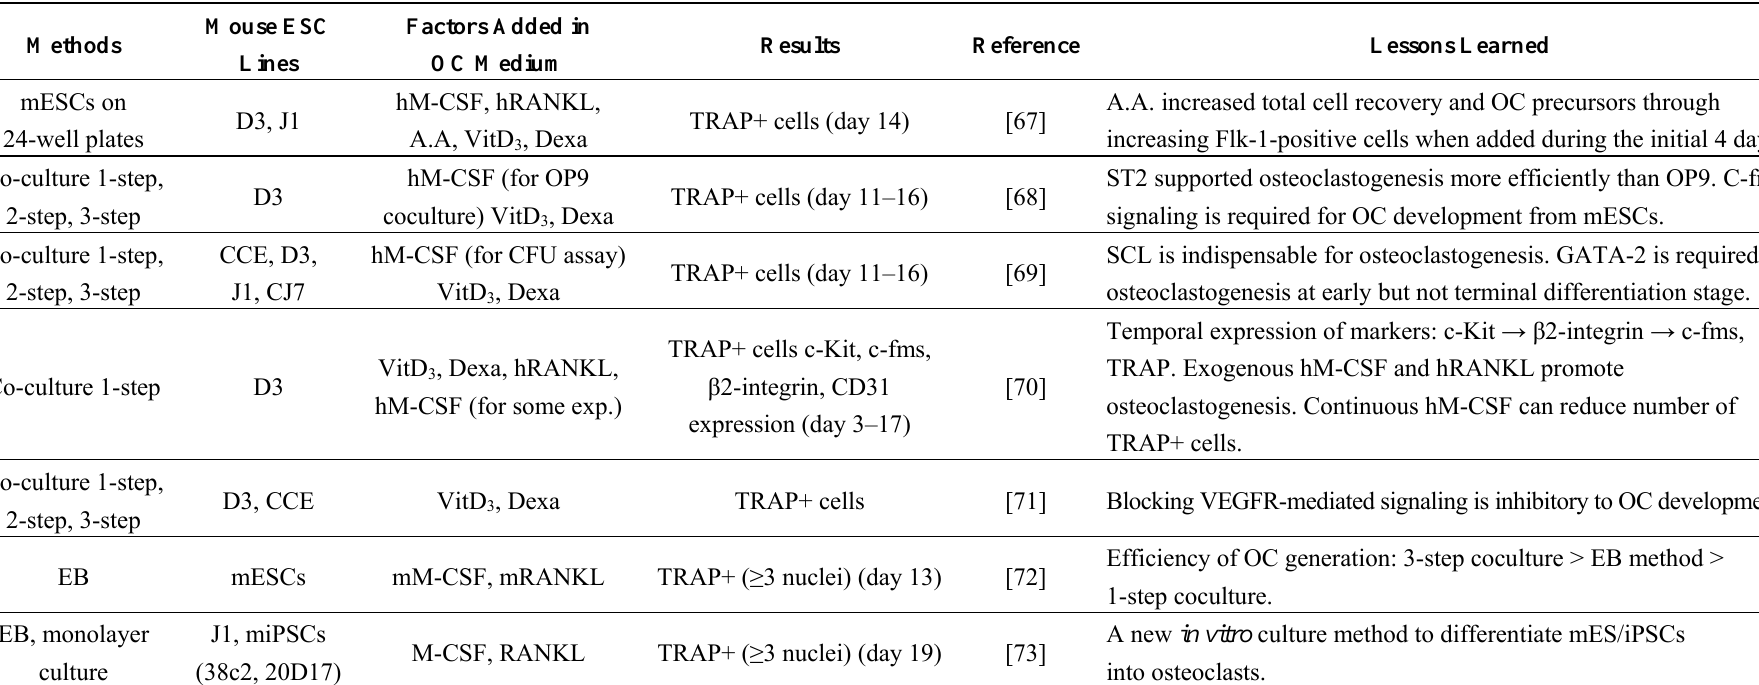
Table 3. Protocols for differentiating mESCs/iPSCs to